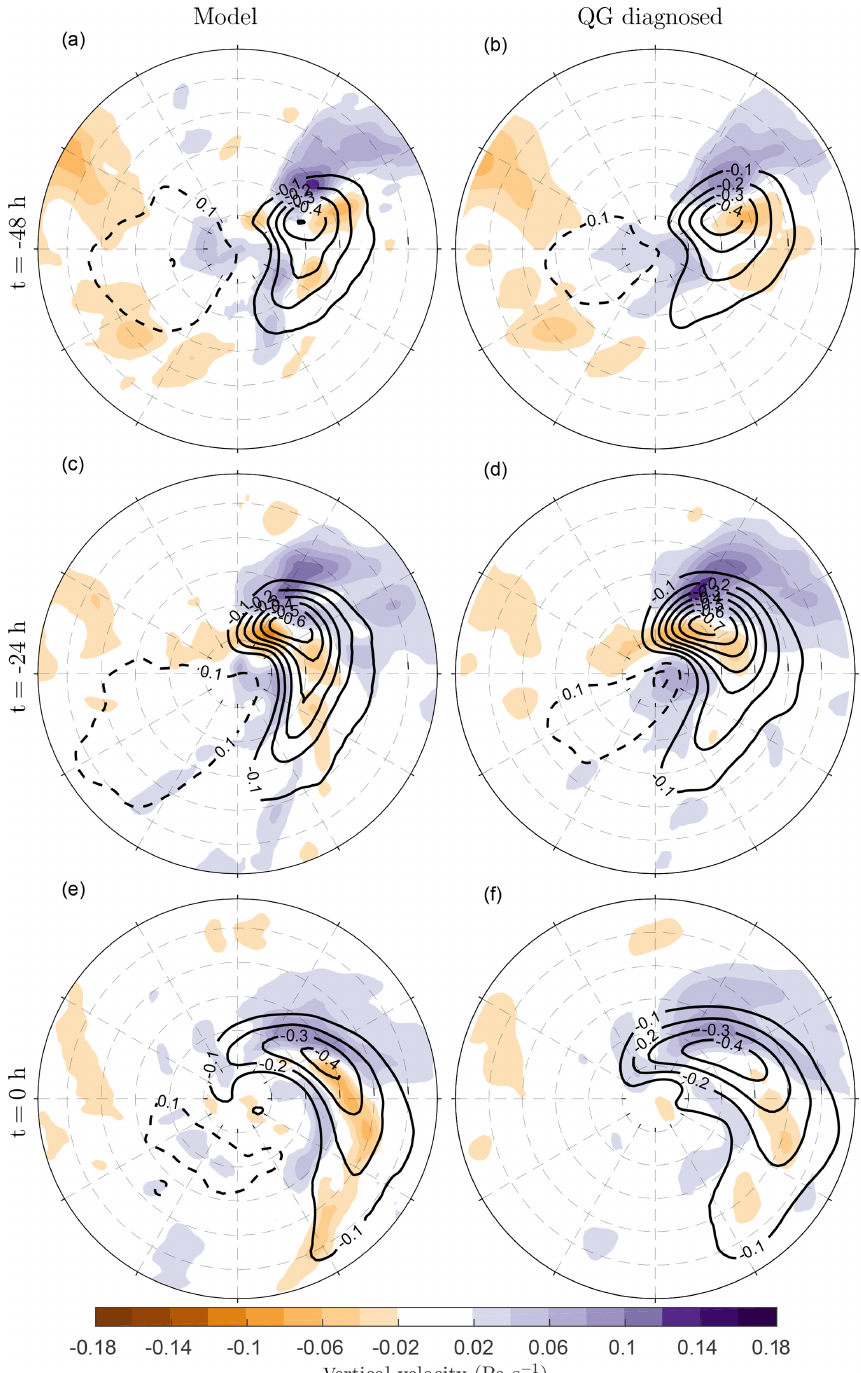
Figure 10. Composite mean and change in 700hPa vertical velocity in pressure coordinates for (a, c, e) total model calculated vertical velocity and (b, d, f) vertical velocity calculated from the modified quasi-geostrophic omega equation (Eq. 1). Panels (a) and (b) are valid 48h before the time of maximum intensity, panels (c) and (d) are valid 24h before the time of maximum intensity, and panels (e) and (f) are valid at the time of maximum intensity. All composites are of the strongest 200 extra-tropical cyclones in each